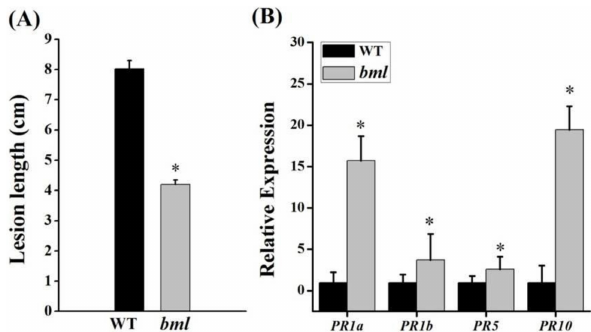
Figure 8. Bacterial blight resistance and expression of resistance-related genes. ( A ) The lesion lengths were measured after inoculating bml and WT plant leaves with the bacterial blight pathogen Xanthomonas oryzae pv. oryzae strain Gz-C. The bars show means ± SD of 10 replicates. ( B ) Expression of pathogenesis-related (PR) marker genes at the tillering stage. All data are shown as means ± SD of five replicates; * p < 0.05 by Tukey’s